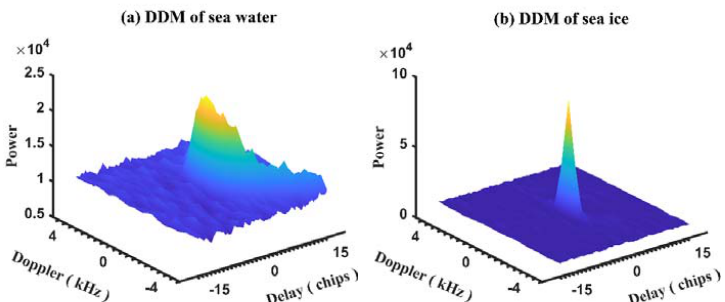
Figure 1. Typical TechDemoSat-1 (TDS-1) Delay-Doppler Maps (DDMs) collected over ( a ) sea water and ( b ) sea ice, respectively.